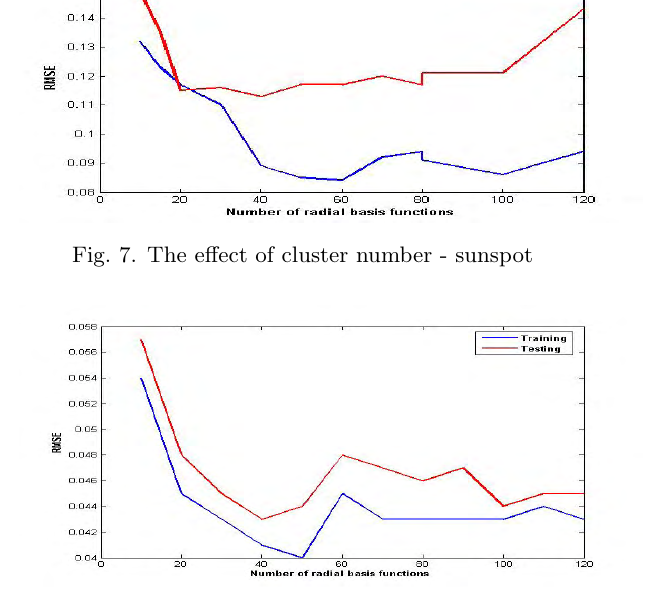
Fig. 6. The effect of the prediction horizon